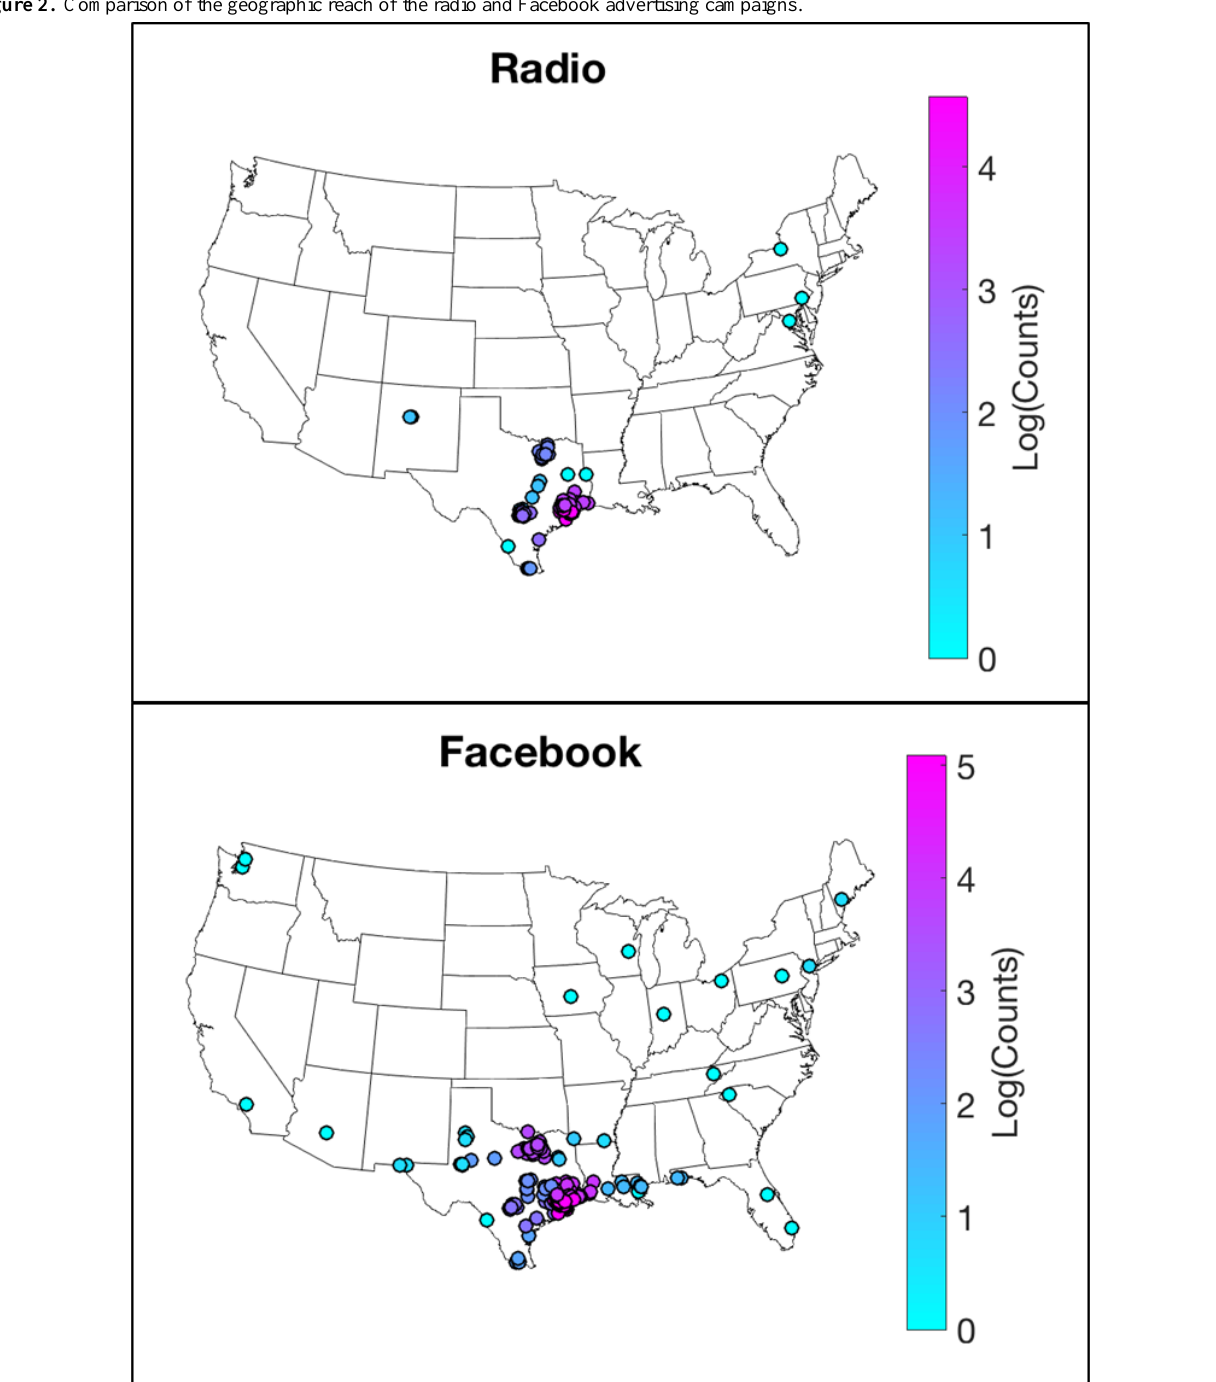
Figure 2. Comparison of the geographic reach of the radio and Facebook advertising